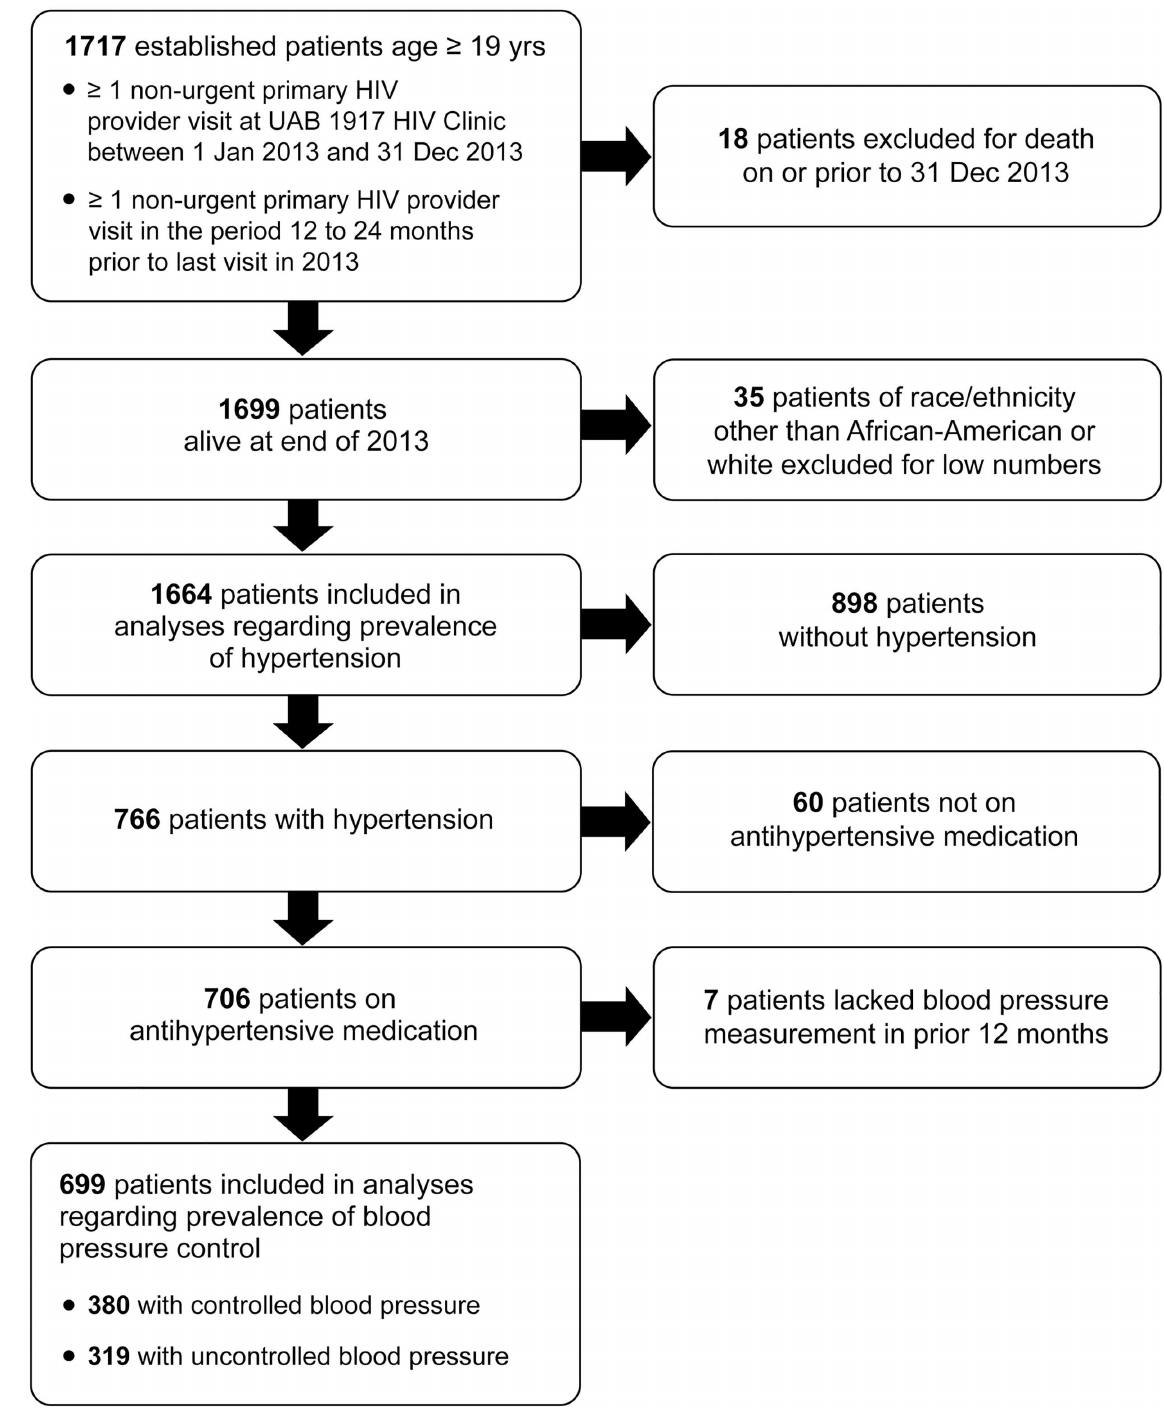
Fig 1. Flow diagram of criteria for inclusion in analyses of hypertension prevalence, treatment, and control among HIV-infected patients attending the UAB 1917 HIV Clinic in 2013.